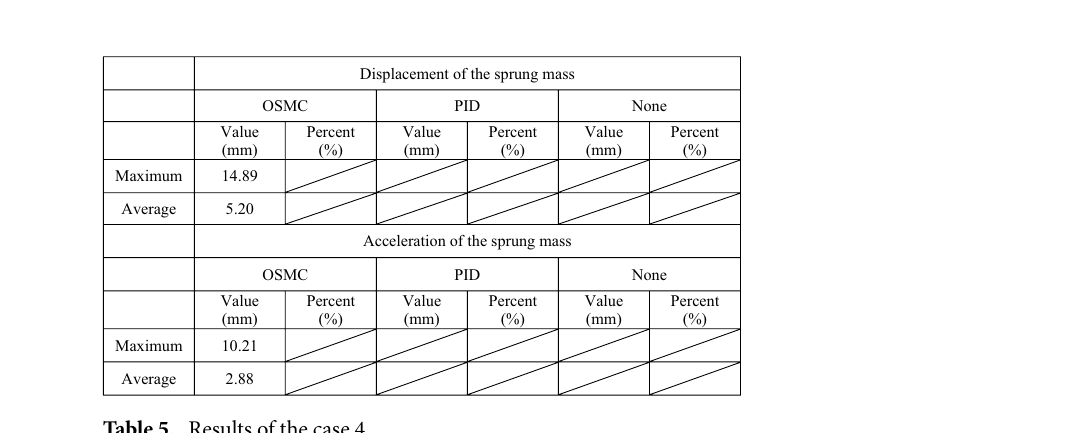
Table 5. Results of the case